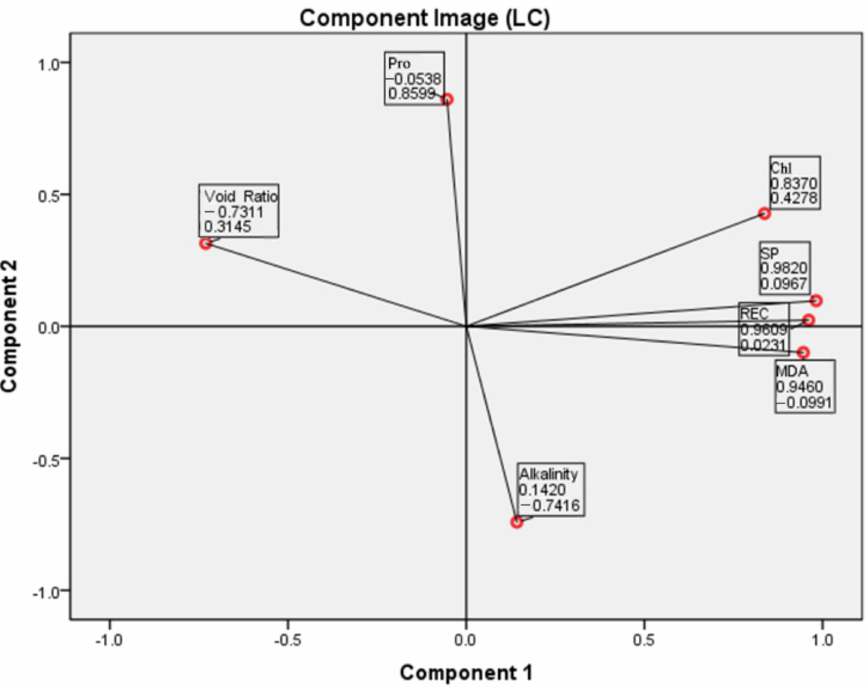
Figure 13. Distribution of the weights of different indexes in the first and second principal components in the LC